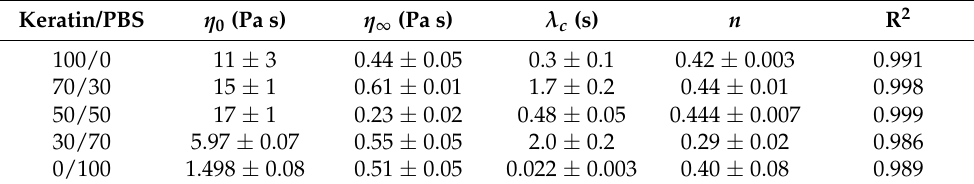
Figure 2. Apparent viscosity ( η ) as function of shear rate ( 𝛾̇ ) of keratin/PBS blend solutions at different blending ratio. Table 1. Carreau model constants of keratin/PBS solutions.